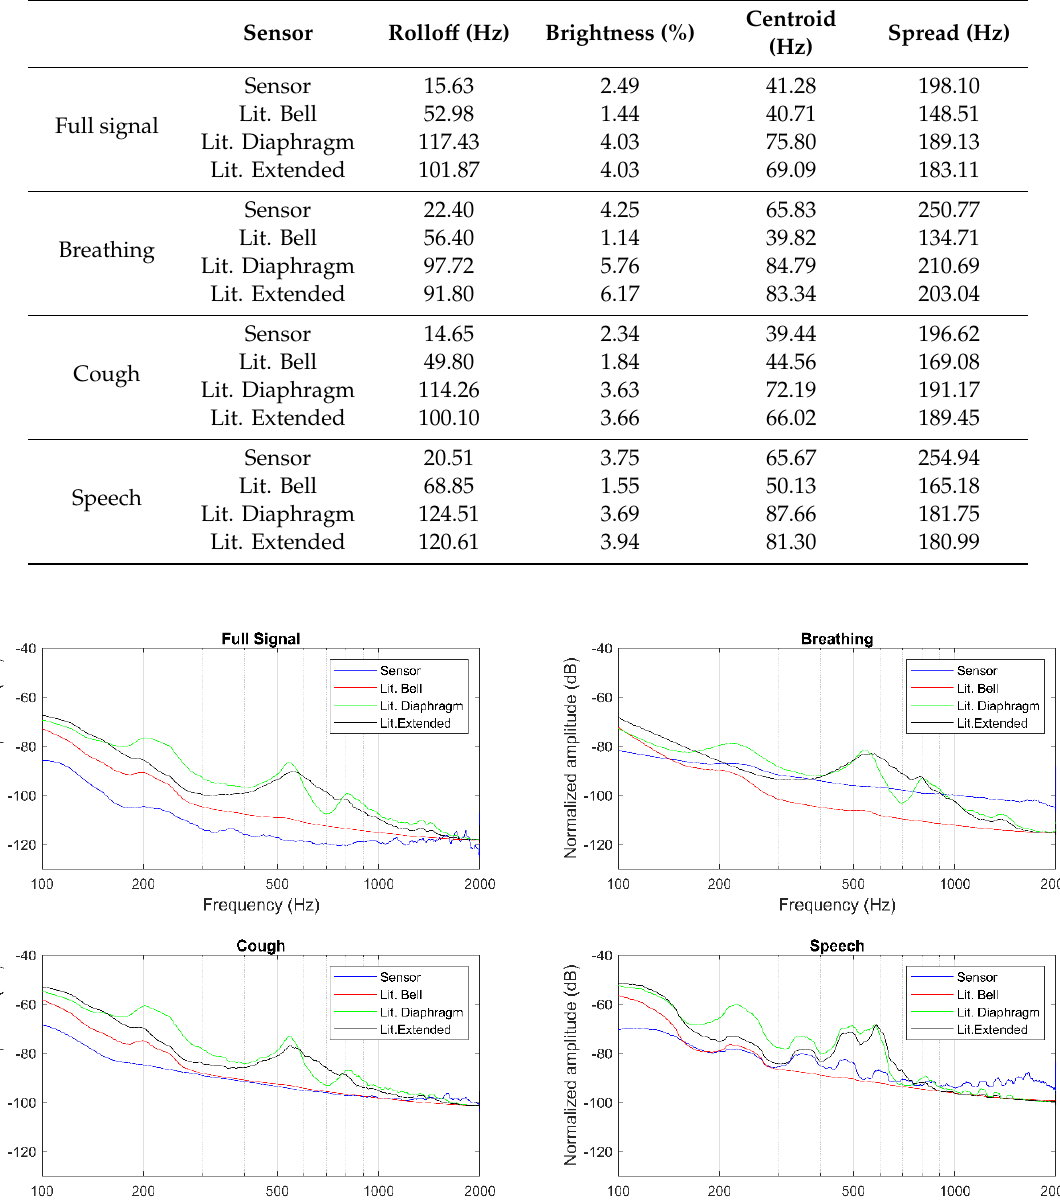
Table 2. Extracted features with respiratory sounds recorded in position 18.